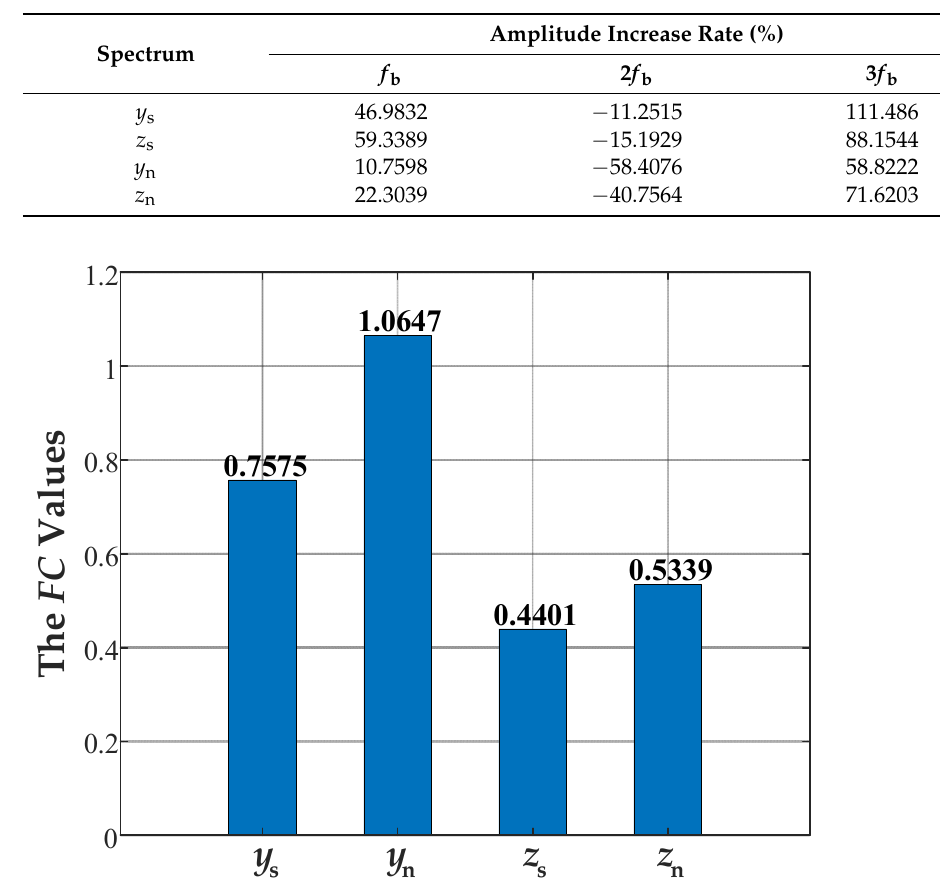
Table 2. Amplitude values around f b , 2 f b and 3f b .